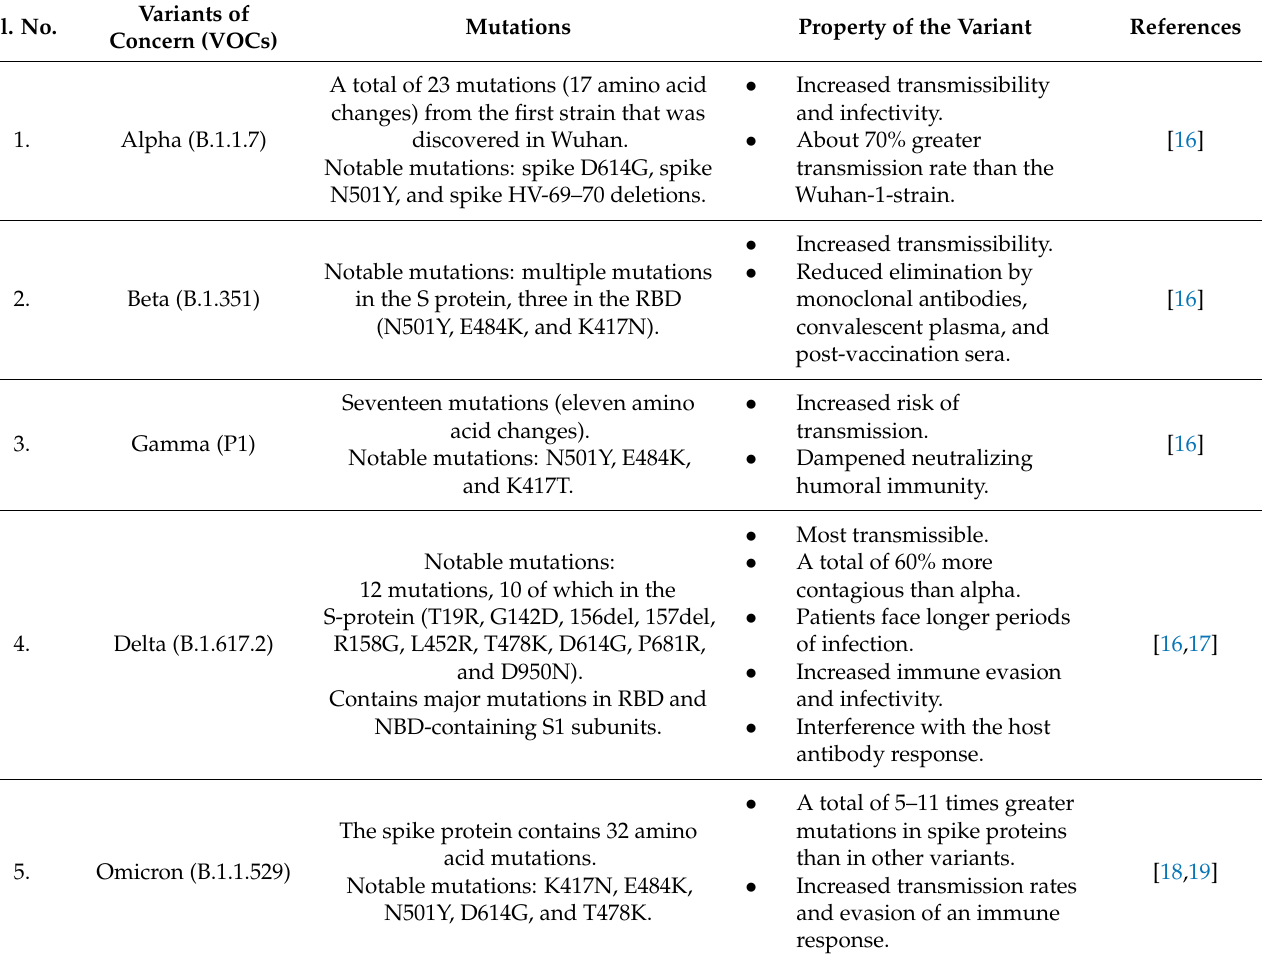
Table 1. Variants of Concern (VOCs) with a global impact (prior to the origin of